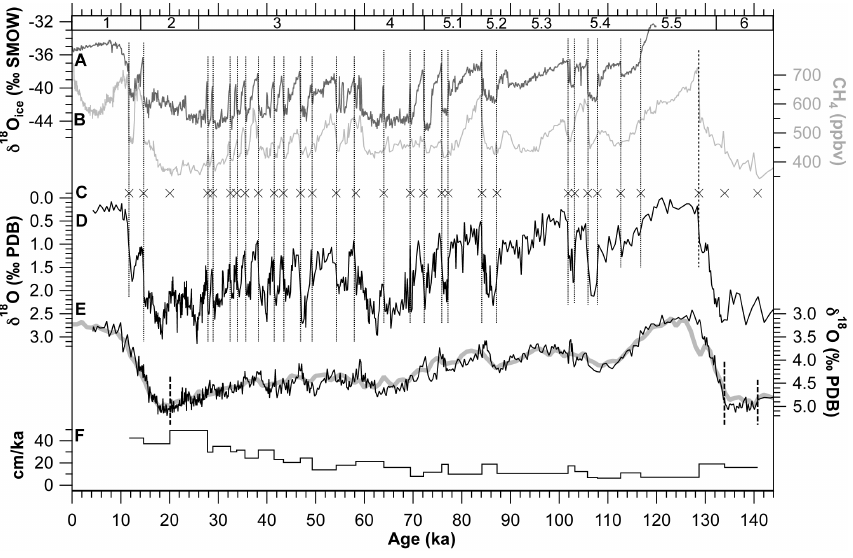
Fig. 2. Revised age model of reference core MD95-2042. (A) NGRIP ice δ 18 O record on the AICC2012 timescale (Bazin et al., 2013; Veres et al., 2013). (B) EPICA Dome C (EDC) methane record (Loulergue et al., 2008) on the AICC2012 timescale (Bazin et al., 2013; Veres et al., 2013). (C) Defined tie points (crosses) in core MD95-2042. (D) Planktic foraminiferal δ 18 O record from core MD95-2042 (Shackleton et al., 2000, 2002). (E.) Benthic foraminiferal δ 18 O record from core MD95-2042 (Shackleton et al., 2000; Shackleton et al., 2002) in comparison to the benthic δ 18 O stack (thick grey line) of Lisiecki and Raymo (2005). (F) Sedimentation rate variations in core MD95-2042. The vertical lines highlight the correlation points between MD95-2042 planktic δ 18 O and NGRIP ice δ 18 O records (dotted lines in A – D ), MD95-2042 planktic δ 18 O and EDC methane records (dashed line at 129ka in B – D ), and MD95-2042 and Lisiecki and Raymo (2005) benthic δ 18 O records (thick dashed lines at 20, 134 and 141ka in E ). Marine isotope stages are indicated at the top of (A)